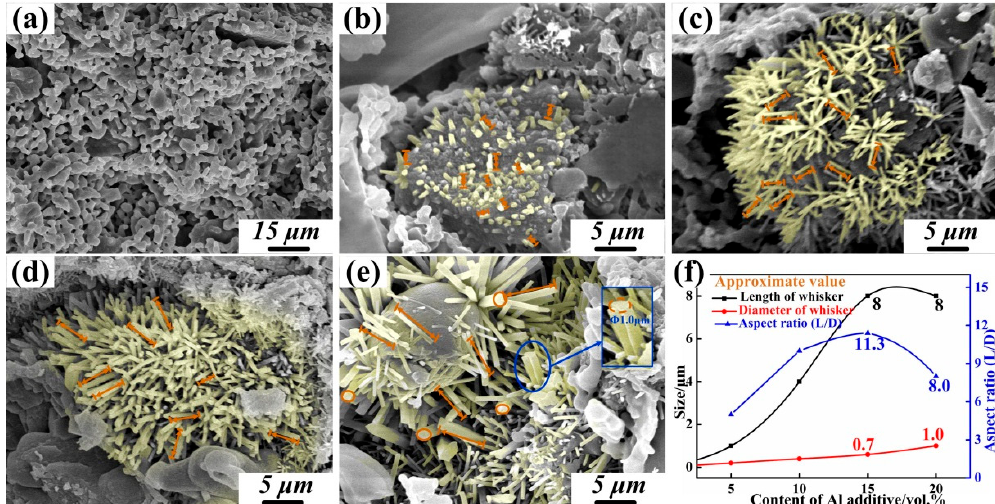
Figure 5. ( a – e ) Scanning electron microscopy (SEM) morphology of mullite whiskers with 0, 5, 10, 15, and 20 vol % Al additive, respectively; ( f ) Size distribution of